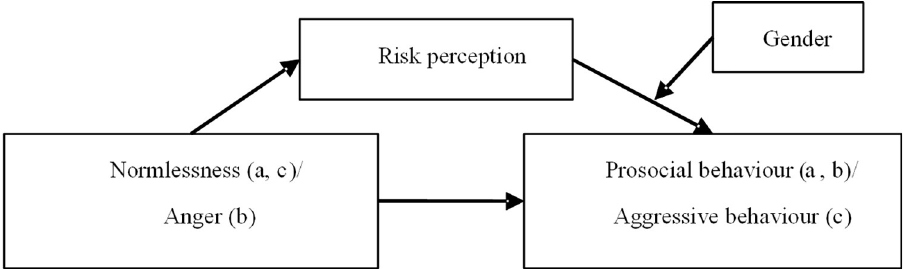
Fig 3. Model a, b, c. Note: Model a shows the effect of normlessness on prosocial driving behaviour, Model b shows the effect of anger on prosocial driving behaviour, and Model c shows the effect of normlessness on aggressive driving behaviour.